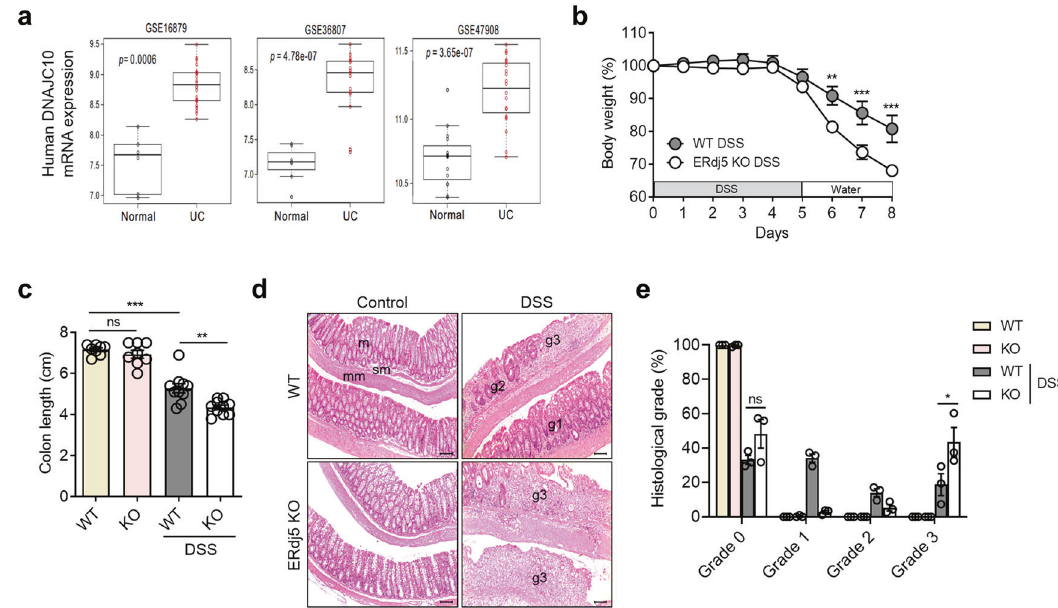
Fig. 1 ERdj5 de fi ciency exacerbates DSS-induced colitis in a murine model. a ERdj5 ( DNAJC10 ) mRNA expression levels in normal controls or patients with ulcerative colitis (UC) were analyzed in the public GEO database. b – e Mice were administered 2% DSS in drinking water for 5 days and subsequently switched to normal water ( n = 8 – 10 per group). b Body weight. c Colon length on Day 8. d Representative histopathological features of the colon in H&E-stained sections (×100, scale bar: 100 µm); m, mucosa; sm, submucosa; mm, muscular layer; pathological grade (g1, g2, g3). e Measurement of the length with different grading scores of in fl ammation in the colon. The data are representative of three independent experiments, and the values are expressed as the mean ± SEM; ** P < 0.01 and *** P < 0.001; ns, not signi fi cant. Two-way ANOVA followed by Bonferroni ’ s test for ( b ) and one-way ANOVA followed by Tukey ’ s test for ( c